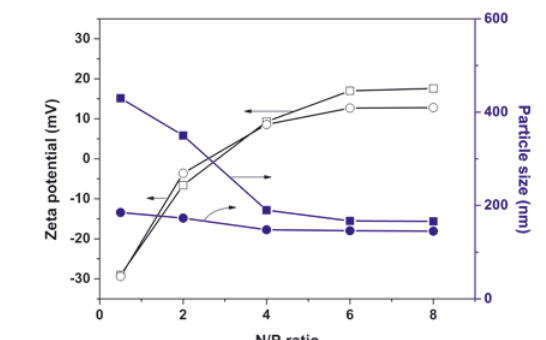
Figure 5. Surface ζ -potential and size of polymer/DNA complexes. The plasmid concentration was 2 μg mL -1 . P30 ( ■ , □ ),